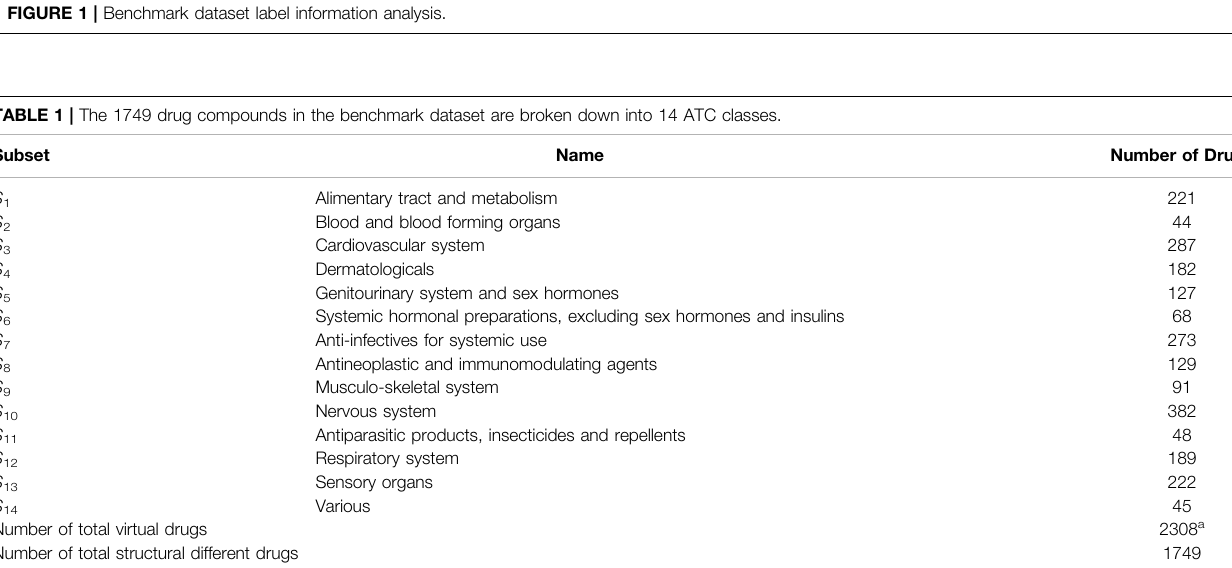
FIGURE 1 | Benchmark dataset label information analysis.